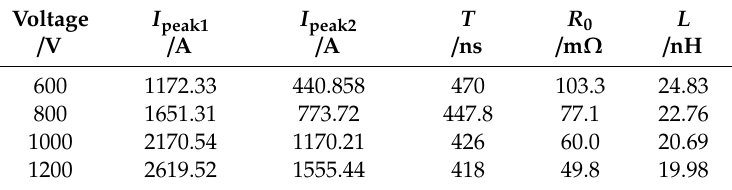
Figure 4. Short-circuit discharge curves at different capacitor voltages. Table 1. Short-circuit discharge parameters at corresponding voltages.